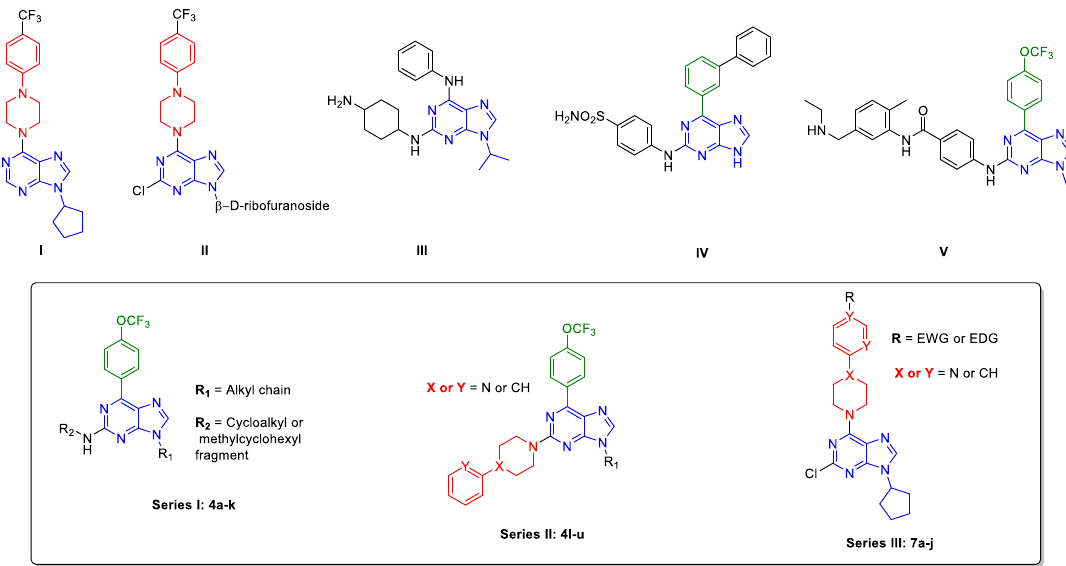
Figure 2. Chemical structures of 2,6,9-trisubstituted purines with biological properties ( I – V ) and proposed compounds of Series I – III .